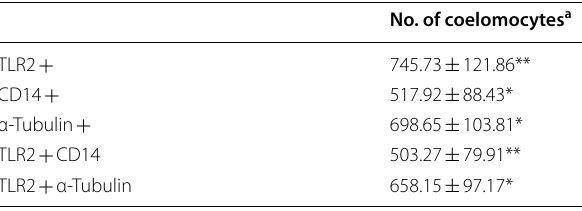
Table 3 Quantitative analysis results (mean values deviations; n =